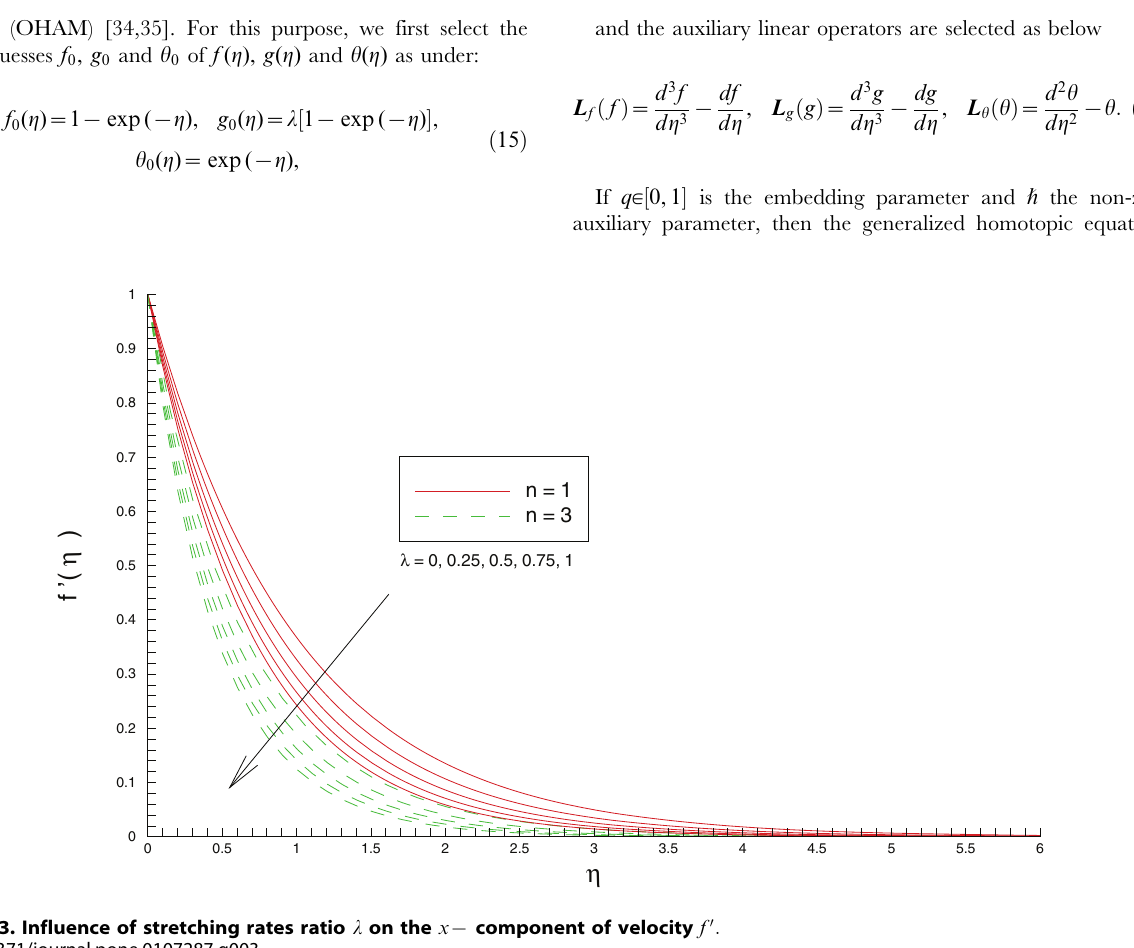
Figure 2. Comparison of analytical and numerical solutions for the temperature distribution. Lines: 15 th -order OHAM solutions, Circles: Numerical solution.